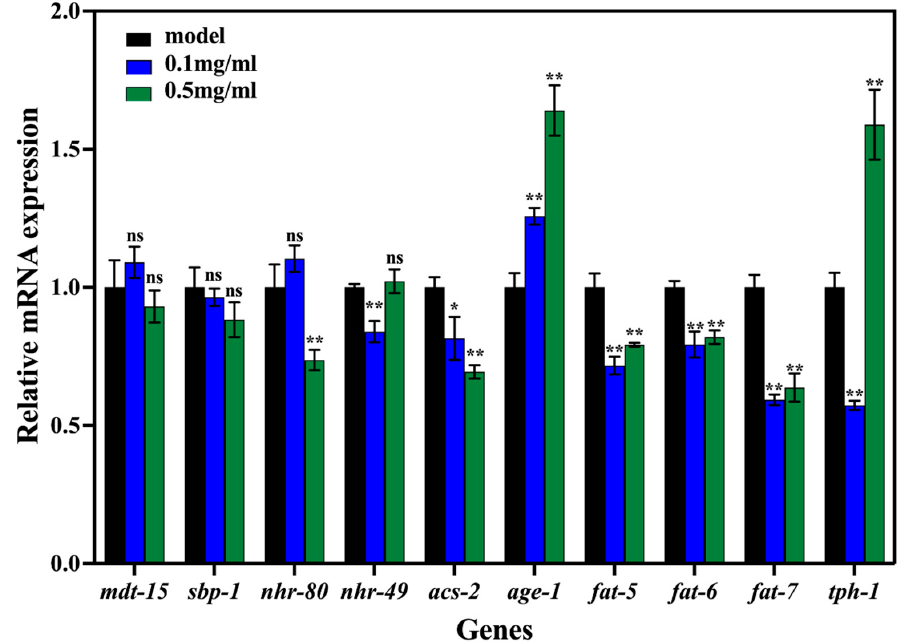
Figure 6. Effects of SPO on the expression of lipid metabolism genes. All data are expressed as mean ± SD, analyzed with ANOVA with the Dunnett’s comparisons test (post-hoc), relative to control * p < 0.05, ** p < 0.01, ns—no